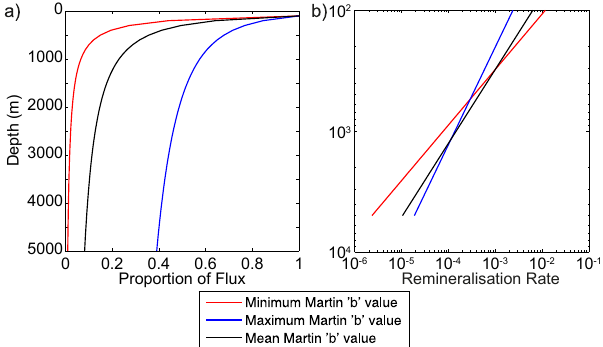
Figure 1. The range of observed Martin curves and associated rem- ineralisation rate profiles. (a) The mean ( b = − 0 . 639) and global range ( b = − 1 . 18 to − 0.24) of Martin curves found by Henson et al. (2012) calculated for a unit flux and export depth ( z 0 = 100m) via (cid:16) z (cid:17) b F z = 1 . (b) The first derivative of each flux curve in panel (a) , z 0 equivalent to a vertical profile of organic matter remineralisation (cid:17) b − 1 (cid:17) (cid:16) z (cid:16) b = R z = 1 calculated as d F z , where R z ; see Martin z 0 z 0 d z 0 0 et al. (1987) for a full